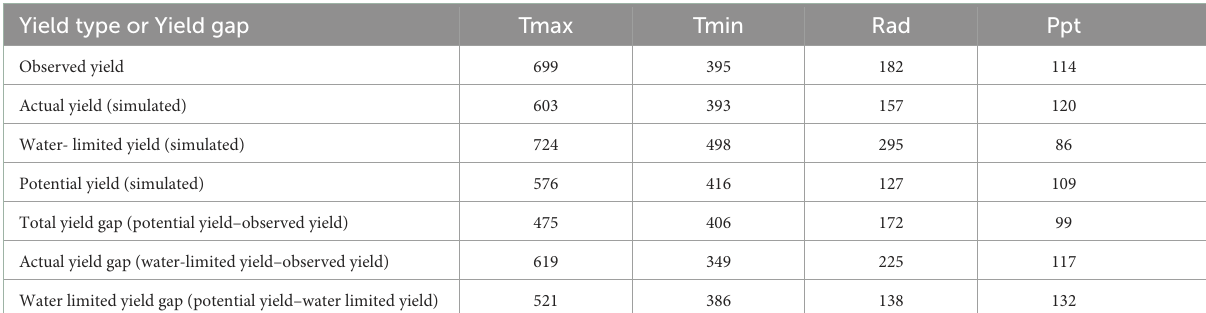
TABLE 4 Feature importance for simulated potential, water-limited, actual yield (nutrient and water-limited), and observed yield (farmer’s yield at the state level in Nigeria) with respect to different climatic variables like Maximum temperature (Tmax), Minimum temperature (Tmin), Radiation (Rad), and Precipitation